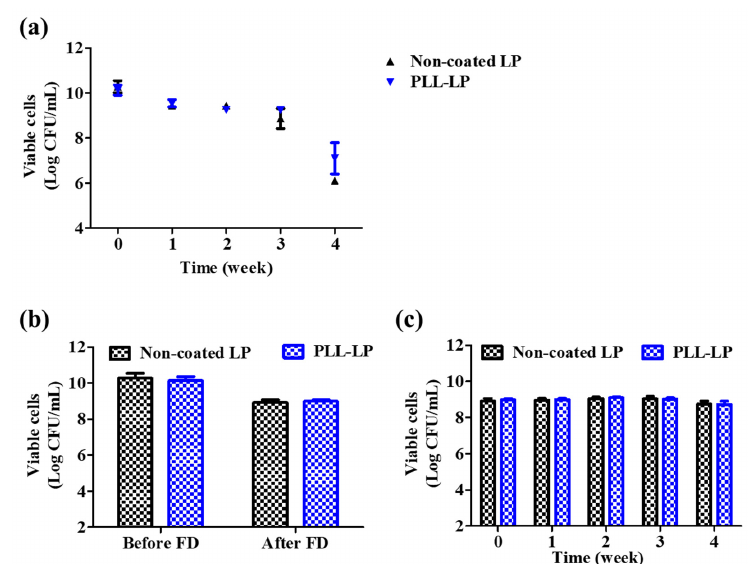
Figure 5. Viability loss of non-coated L. plantarum (non-coated LP) and PLL-coated L. plantarum (PLL- LP) after freeze-drying and storing (at 4 ℃ and − 20 ℃ ). ( a ) Freshly prepared cells stored at 4 ℃ for 4 weeks. ( b ) Before and after freeze-drying. ( c ) Freeze-dried cells stored at − 20 ℃ for 4 weeks. The error bar represents the standard deviation ( n = 8).